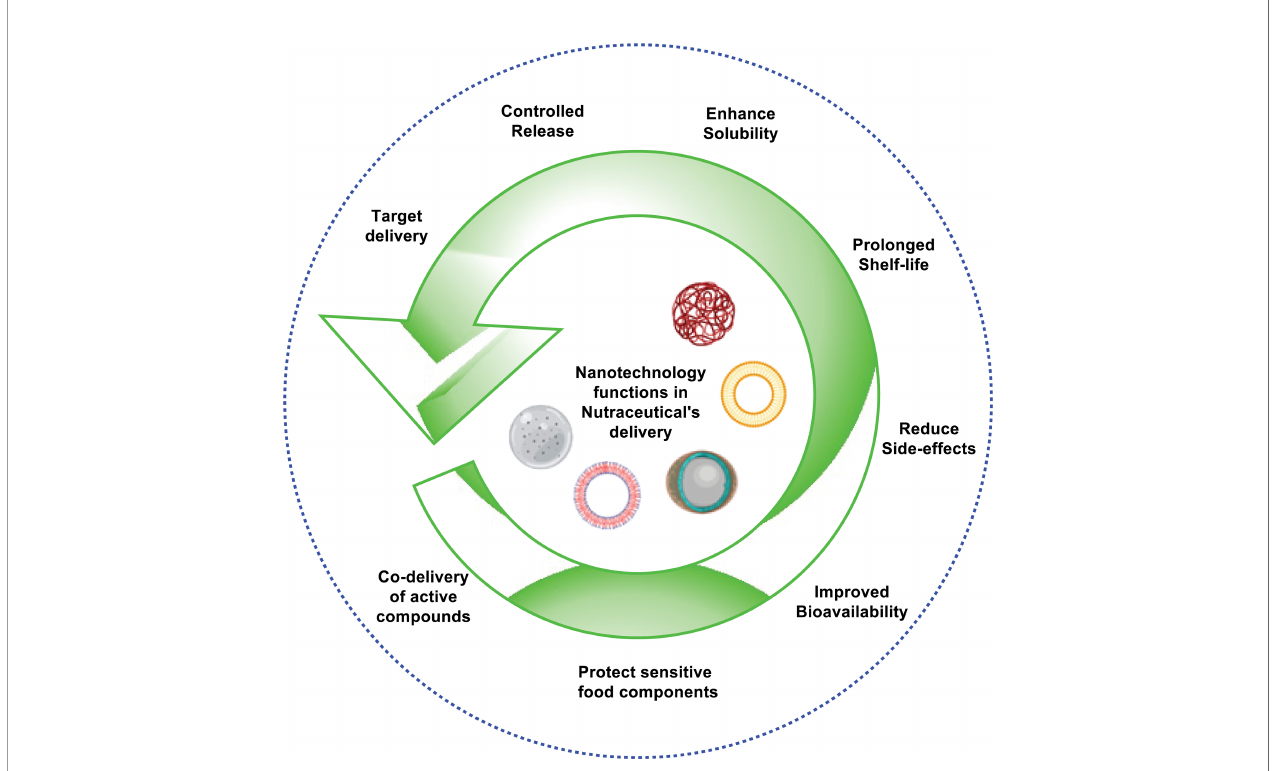
FIGURE 1 | Role of nanotechnology in nutraceutical ’ s delivery